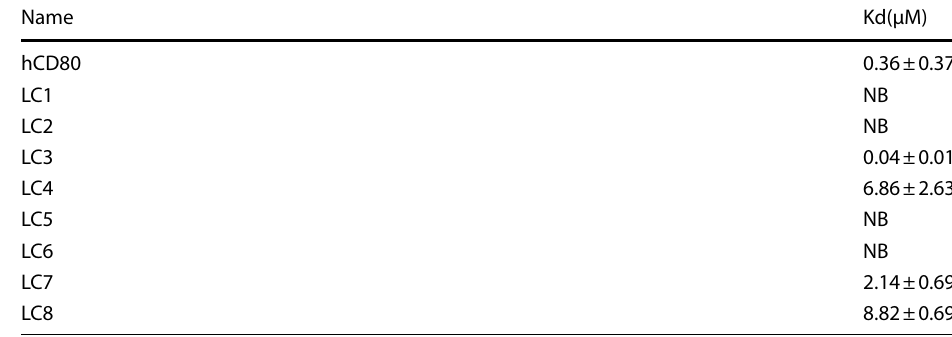
Table 2 The human CTLA4 binding peptides to hCTLA-4 protein affinity was measured by